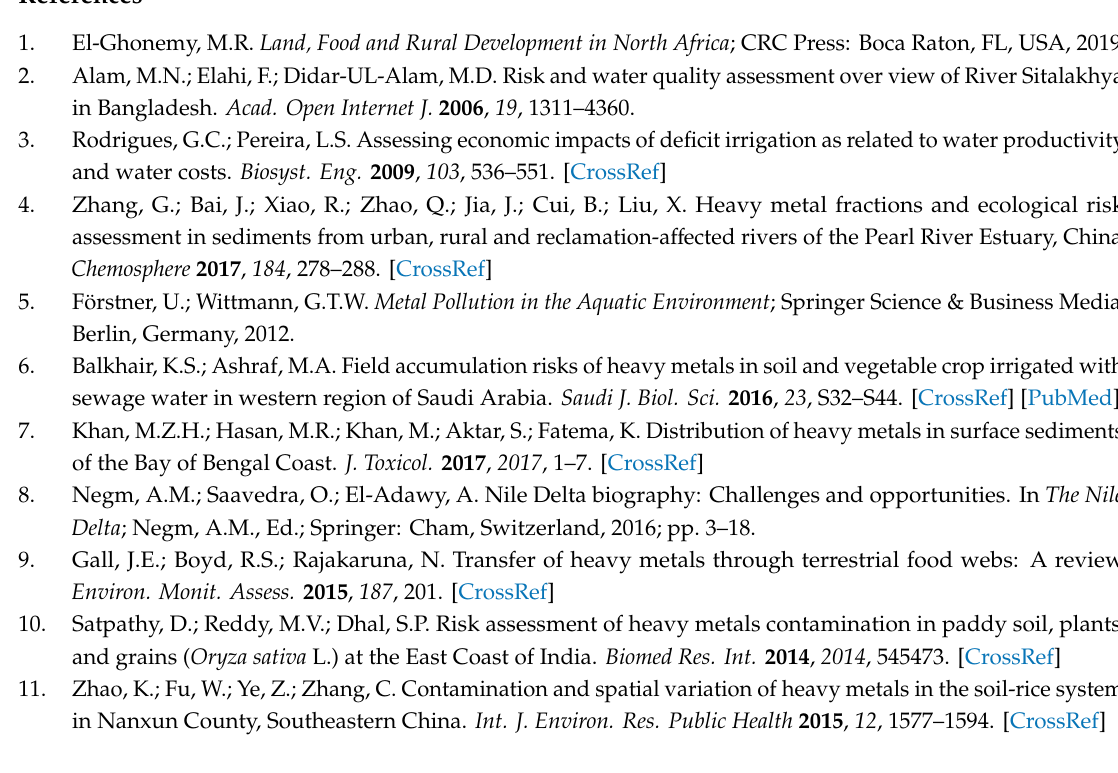
Table S1: Pearson correlation matrix various sediment parameters and heavy metals from the three studied drains in Nile Delta, Table S2: Microelement concentrations (mg / kg) in roots and shoots of three studied emergent hydrophytes naturally growing along studied drains, Table S3: Results of analysis of variance of various studied heavy metals in either roots or shoots of Echinochloa stagnina , Phragmites australis , and Typha domingensis collected from the three studied drains in Nile Delta. Table S4: Comparison among the three plant species ( Echinochloa stagnina , Phragmites australis , and Typha domingensis ) based on the bioaccumulation factors of root and shoot as well as the translocation factor. Table S5: Various pollution indices formulas used in the present study, Table S6: Classes of used indices for metals in the present